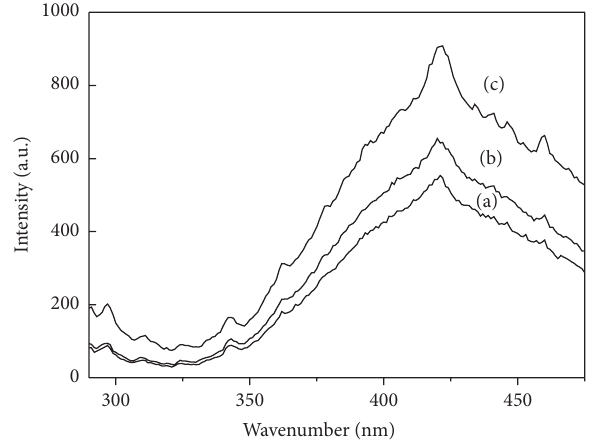
Figure 4: PL spectra of the CaWO 4 nanoparticles synthesized at 120 ∘ C for (a) 5min, (b) 10min, and (c)